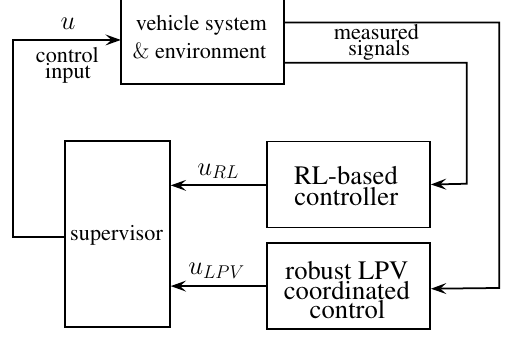
Figure 1. Framework for coordinated control